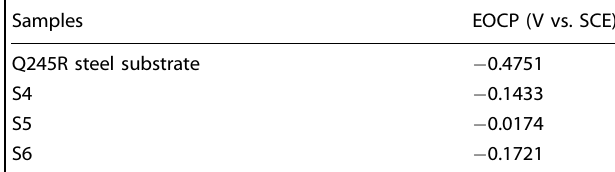
Table 3. Wear mass loss and bulk loss of Q245R, Inconel 625 coatings on Q245R steel (S4, S5, S6) after 1200 s friction and wear test.